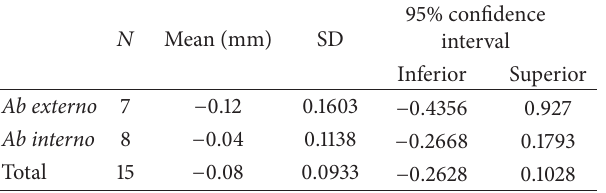
Table 2: Intraocular lens position in relation to the iris (IOL tilt) in the horizontal plane (3 and 9h), considering UBM findings.